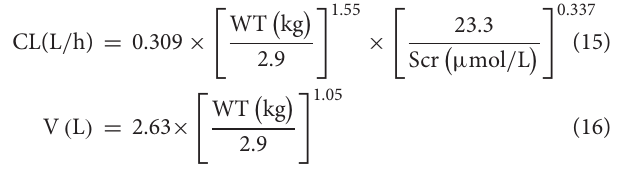
Frontiers in Pharmacology |